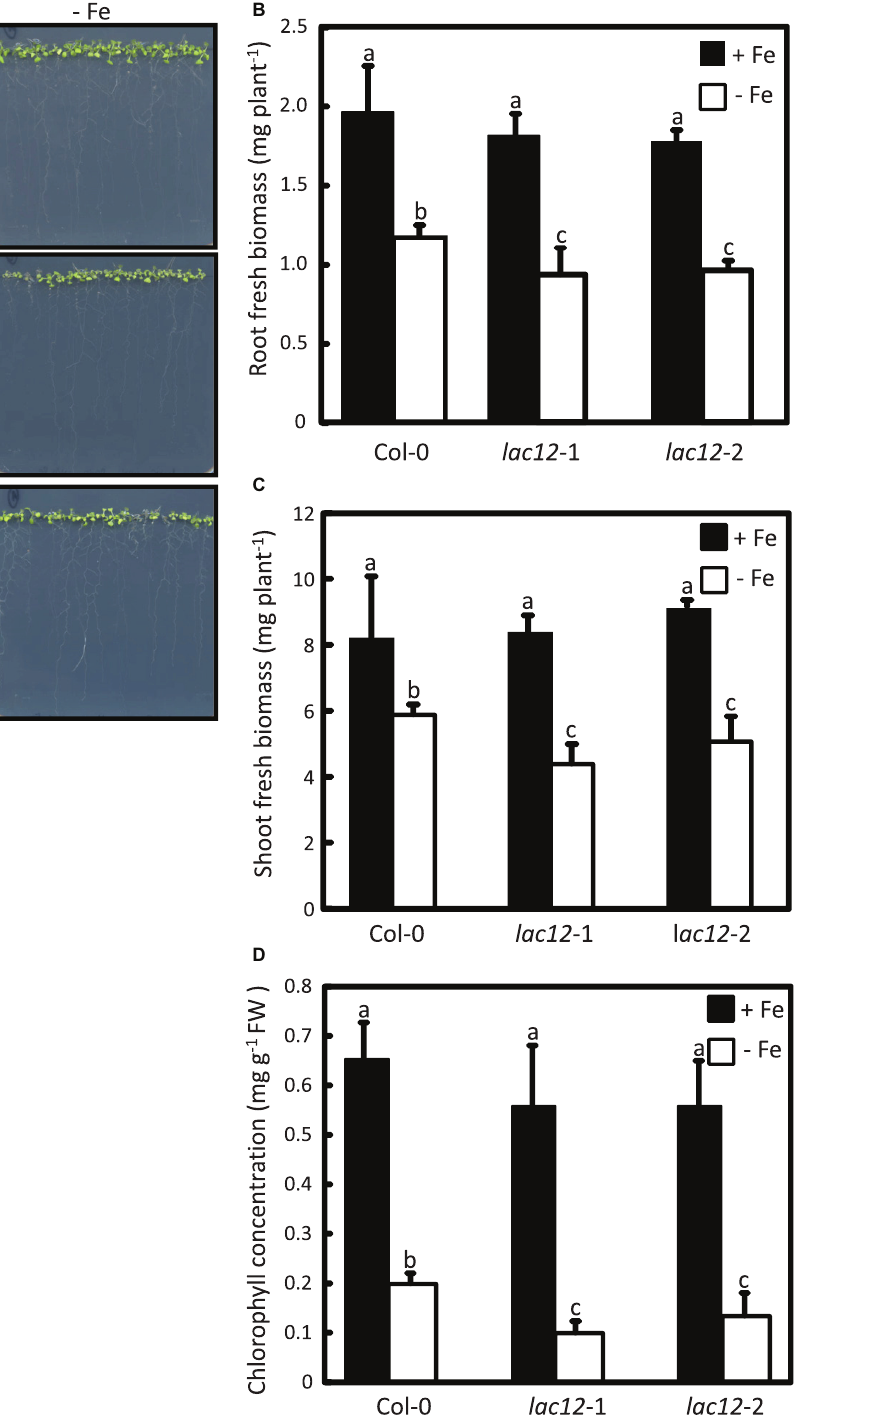
FIGURE 3 | Arabidopsis lac12 mutants are more sensitive to Fe deficiency than the wild-type. (A) Photographs of 15-day-old seedlings of WT, lac12- 1 and lac12- 2 mutant lines grown in standard Hoagland’s medium for 10 d (5 µ M FeHBED; unwashed agar) followed by a growth period of 5 d on Fe-sufficient (+Fe, 10 µ M FeHBED) and Fe-deficient (-Fe, 0 µ M FeHBED) agar-solidified Hoagland’s medium (EDTA-washed agar), on vertically oriented petri plates. Photographs are from one experiment representative of three independent experiments. Fresh biomass of (B) roots and (C) shoots, and (B) leaf chlorophyll content of WT, lac12 -1 and l ac12 -2 seedlings grown on vertically oriented petri plates as described above. Bars show arithmetic means ± SD of three replicate plates, with 20 seedlings per plate, from one experiment representative of three independent experiments. Each replicate consisted of pooled material of 20 seedlings from one plate (B and C) , or 5 seedlings per replicate plate (D) . Different characters denote statistically significant differences ( P < 0.05) between means based on ANOVA (Tukey’s HSD).